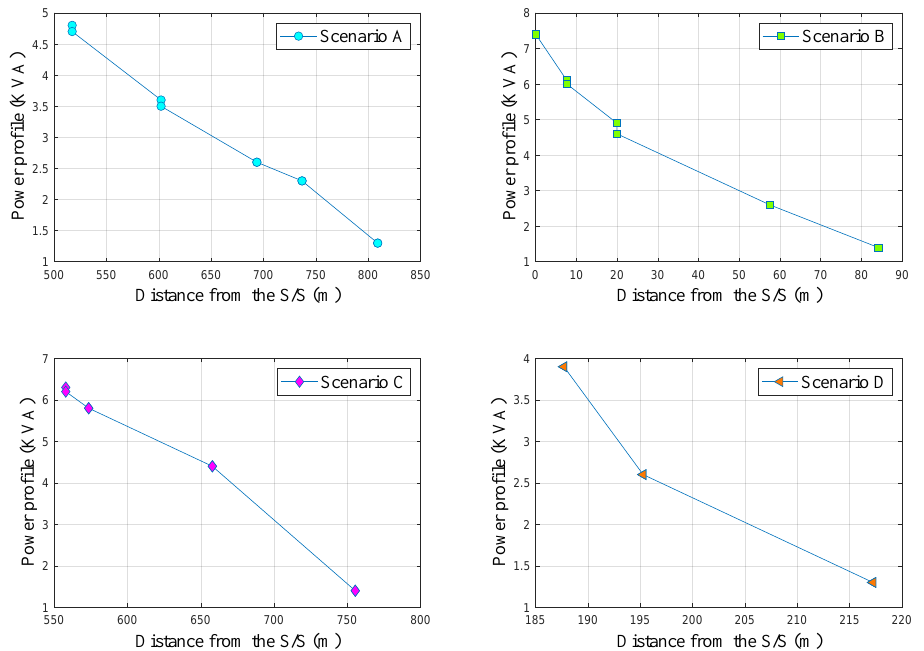
Figure 8. Power profile in (kVA) of the study